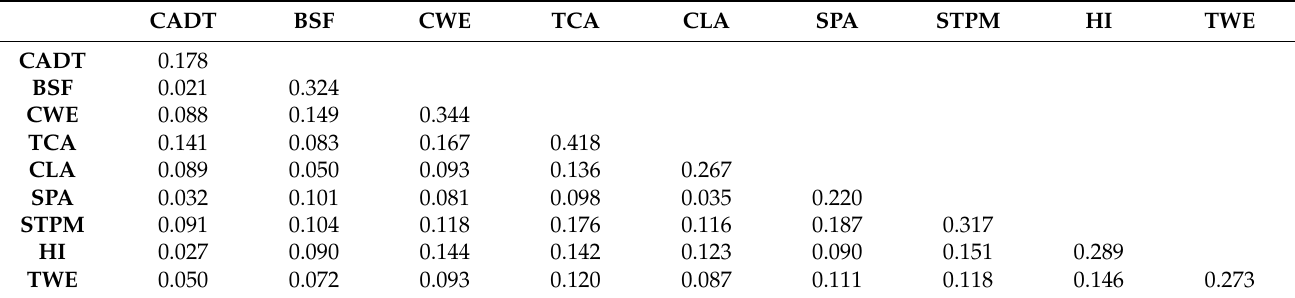
Table 5. Correlation matrix and discriminant validity for the